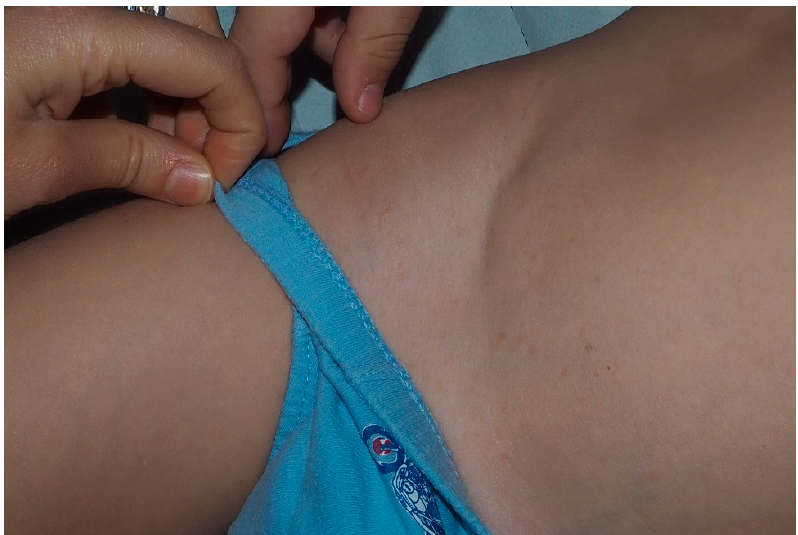
Figure 7. Precocious freckling of inguinal area of a young patient.